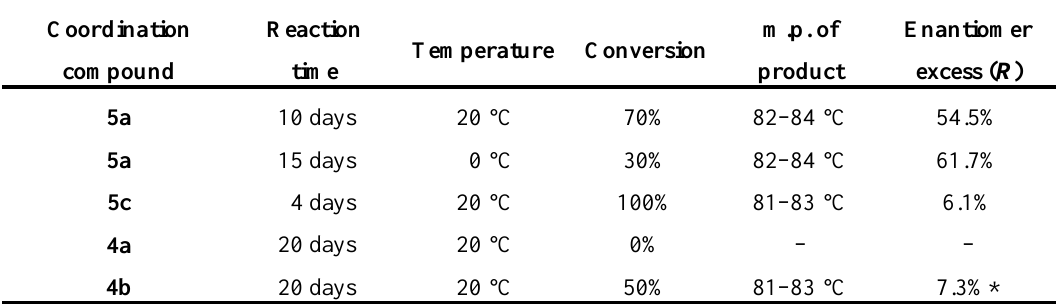
Table 1. Nitroaldol addition of nitromethane with 4-nitrobenzaldehyde catalysed by coordination compounds 5a, 5c and 4a, b .